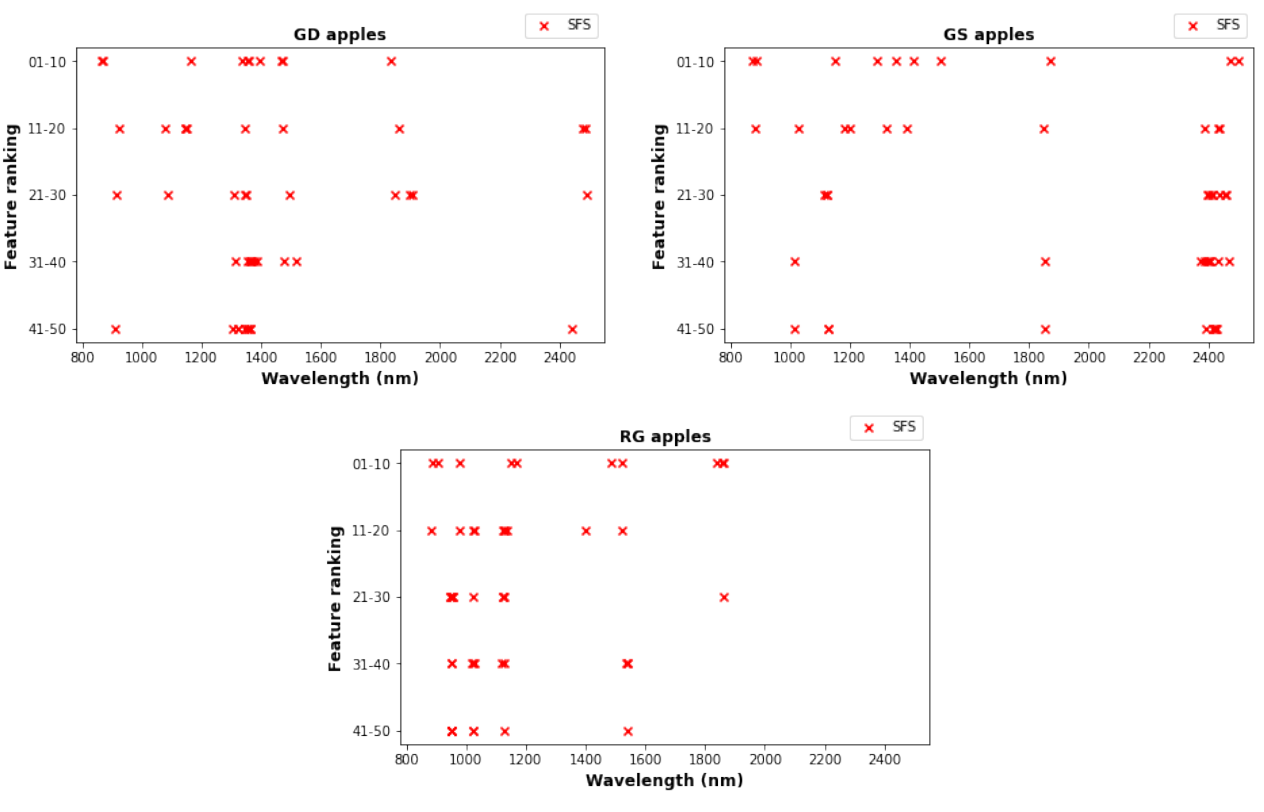
Figure 5. Allocation of the 50 selected features that are most relevant to bruise segregation for the three cultivars. Selected wavelengths are plotted in sets of 10 with the first selected on top. Detailed frequency information is given in Appendix